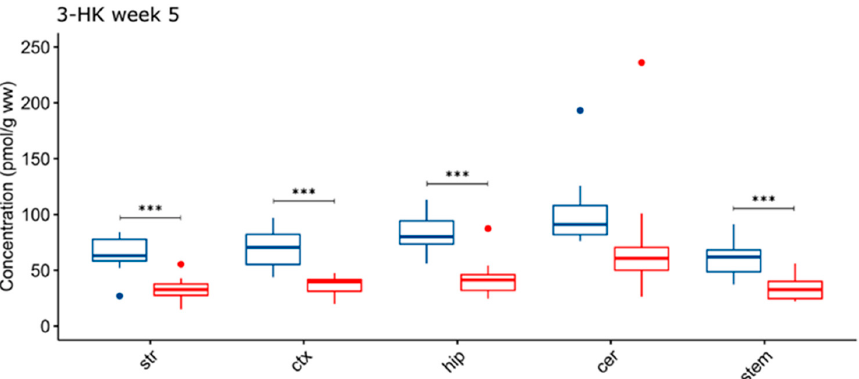
Figure 5. Decreased 3-hydroxy-L-kynurenine concentrations in certain brain regions in time pro- gression in the cuprizone-treated group. A significant difference in 3-HK levels emerged between the groups as the damage caused by the CPZ treatment worsened. 3-HK: 3-hydroxy-L-kynurenine; CO: control group; cer: cerebellum: CPZ: cuprizone group: ctx: cortex; hip: hippocampus; stem: brainstem; str: striatum; ww: wet weight; *: p < 0.05; **: p < 0.01; ***: p < 0.001. In addition, in the 3rd week of treatment, an increase in TRP concentration was observed in the cortex and hippocampus in the CPZ group. The elevated TRP level became even more apparent by the 5th week of CPZ intoxication, and it was also increased in the striatum and likewise in the cortex and the hippocampus (Figure 6).